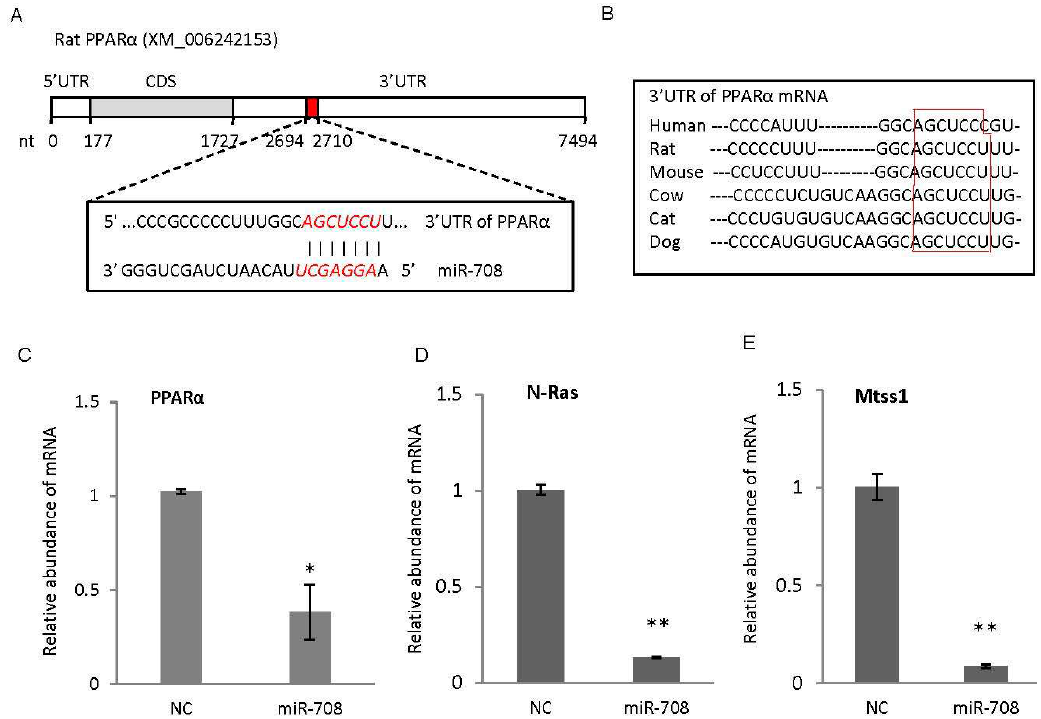
Figure 4. miR-708 mimics interacted with predicted target genes in cardiac stem/progenitor cells. ( A ) One binding site to miR-708 (shown in red) was identified from 3 ′ untranslated region (3 ′ UTR) of peroxisome proliferator-activated receptor alpha α (PPAR α ) mRNA in rat; ( B ) The miR-708 binding site in PPAR α mRNA is highly conserved between species as shown in red box; ( C ) Quantitative real-time PCR confirmed the decreased level of PPAR α in CSCs/CPCs after transfection with miR-708; ( D , E ) Quantitative real-time PCR confirmed the decreased level of N-Ras ( D ) and Mtss1 ( E ) in CSCs/CPCs after transfection with miR-708. N-Ras and Mtss1 have been reported to be two target genes of miR-708 in rat. β -actin was used for normalization. Data are mean ± SEM ( n = 3). * p < 0.05, ** p < 0.01.